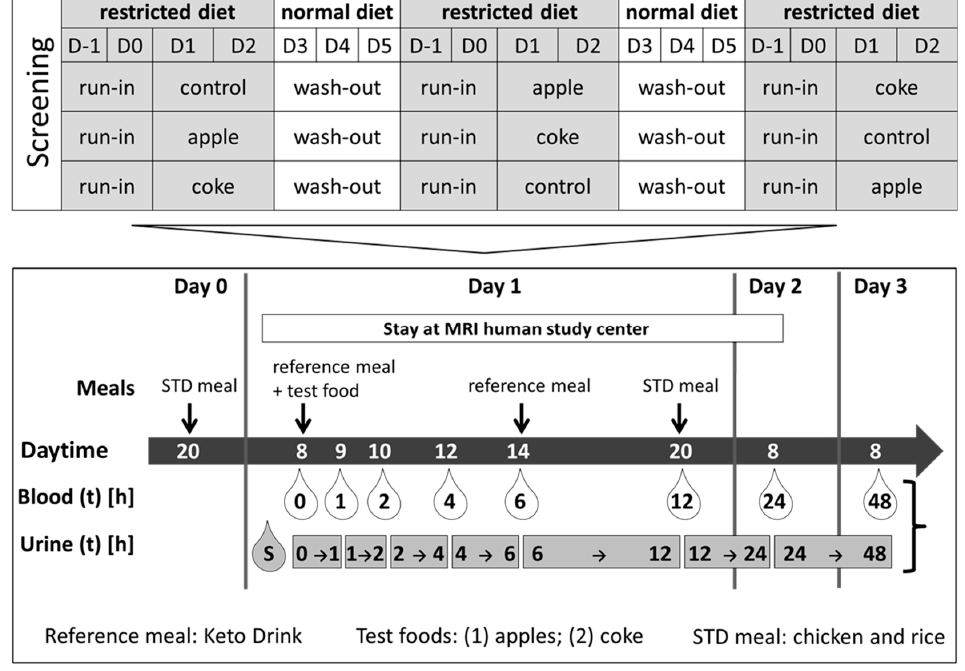
Figure 5. Study design of the randomized, controlled crossover study.